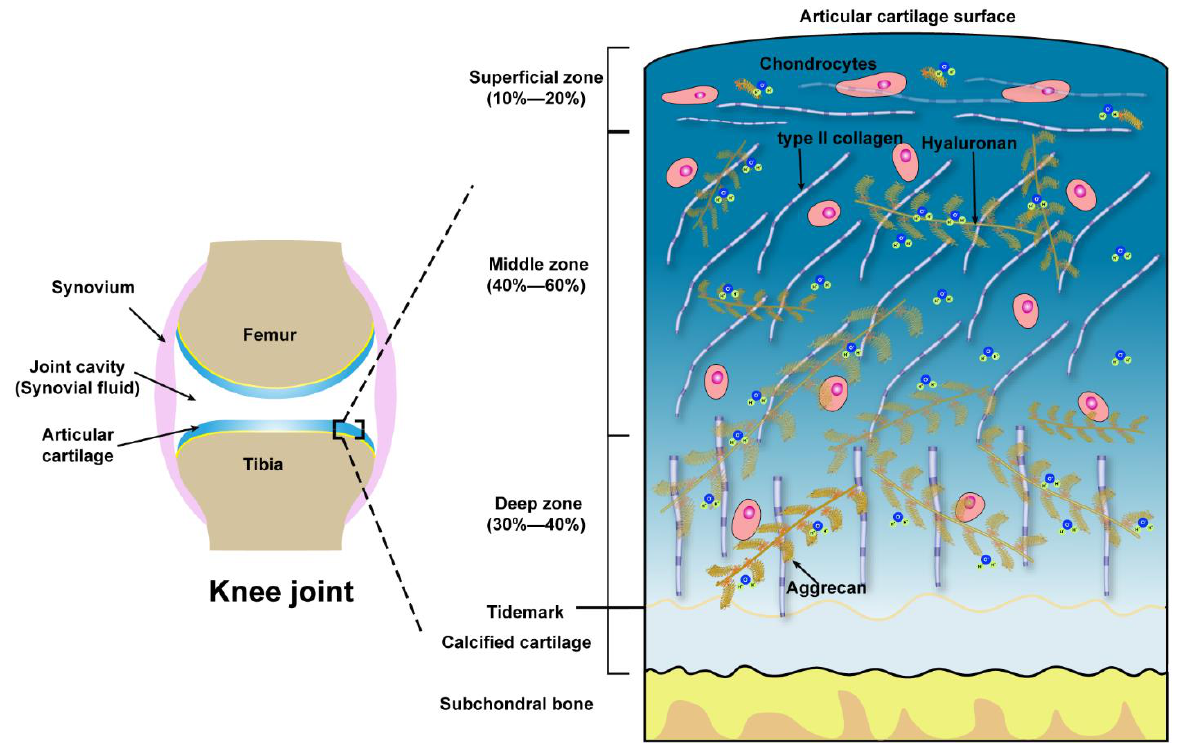
Figure 1. Schematic illustration of the knee joint and the structure, compositions of articular cartilage from the surface to subchondral bone. Table 1. The main biomechanical properties of the superficial zone, middle zone, and deep zone of articular cartilage. Zones Extracellular